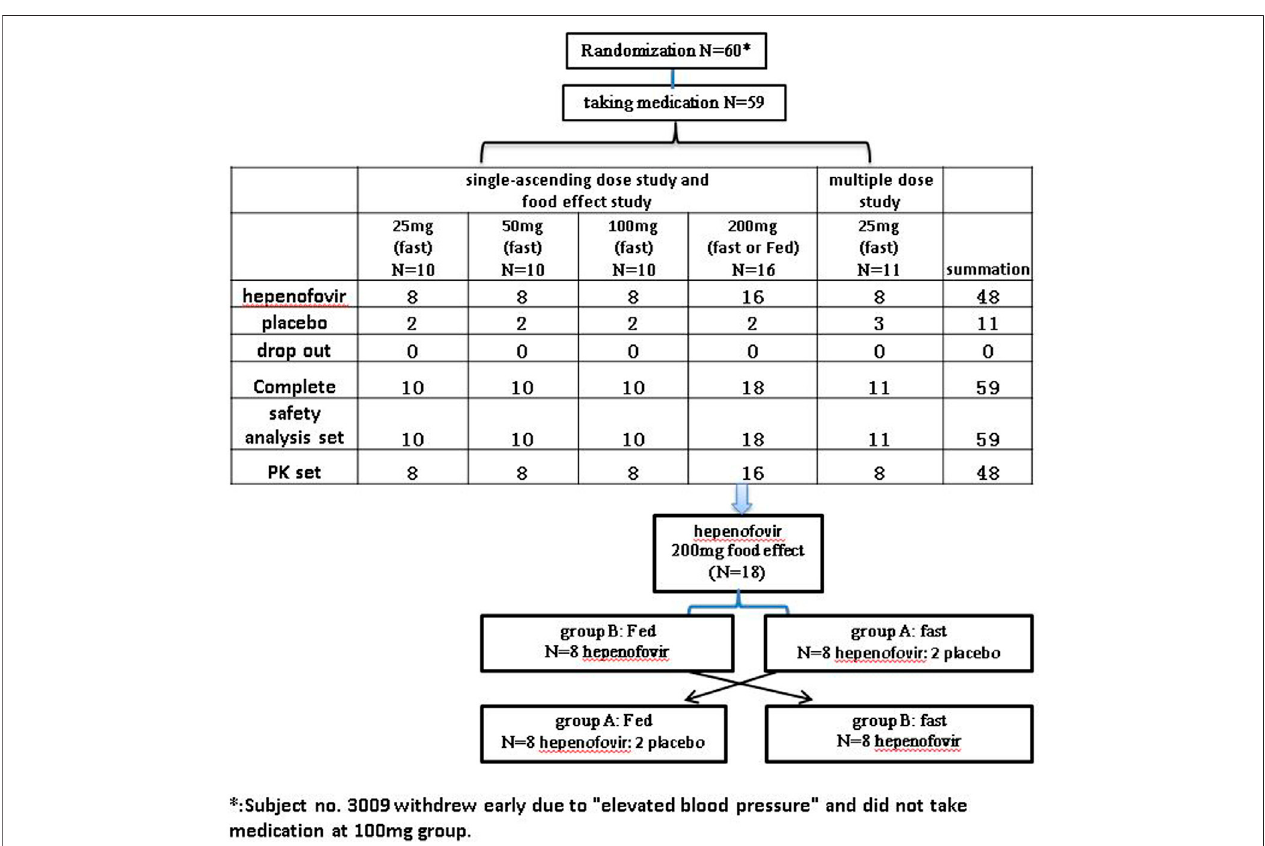
FIGURE 1 | Flow-chart depicting the variables examined in the